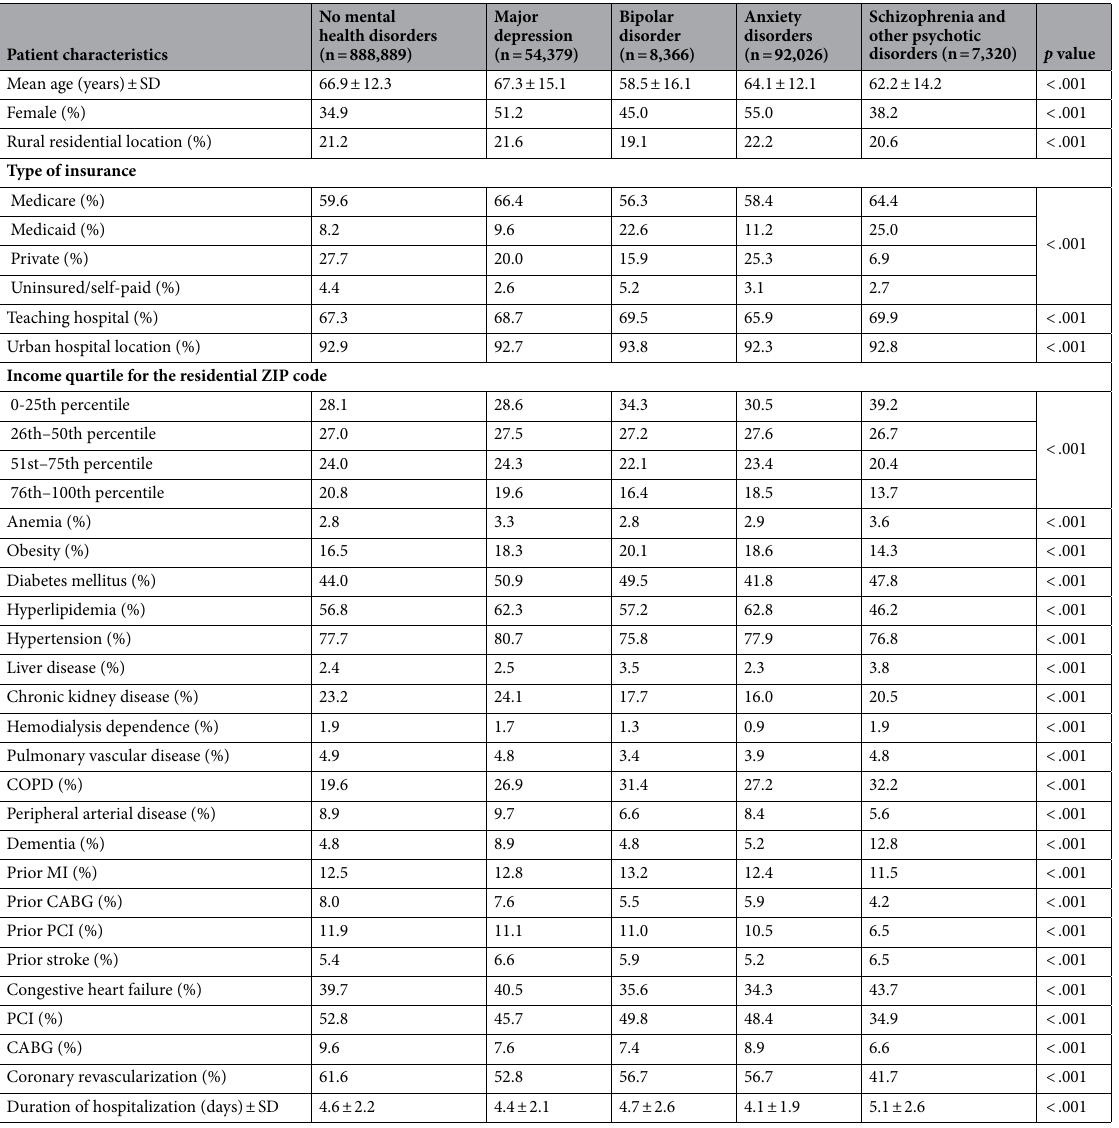
Table 1. Baseline characteristics of study population stratified by mental health disorders. CABG coronary artery bypass grafting, COPD chronic obstructive pulmonary disease, MI myocardial infarction, PCI percutaneous coronary intervention, SD standard